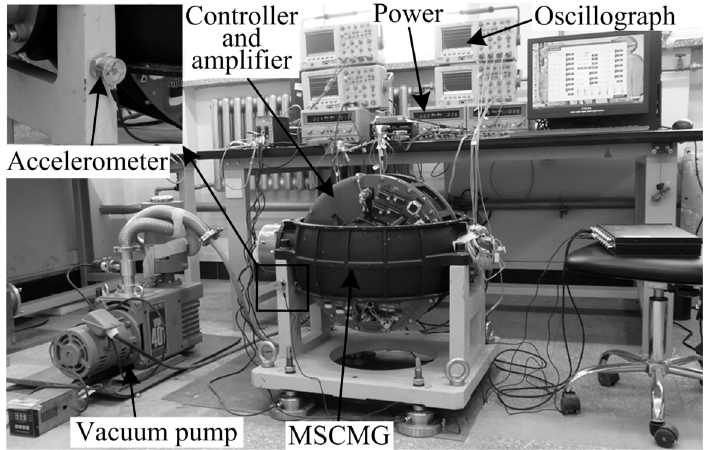
Figure 7. The picture of the experiment setup. Table 1. Parameters of the AMB system with the proposed control approach.